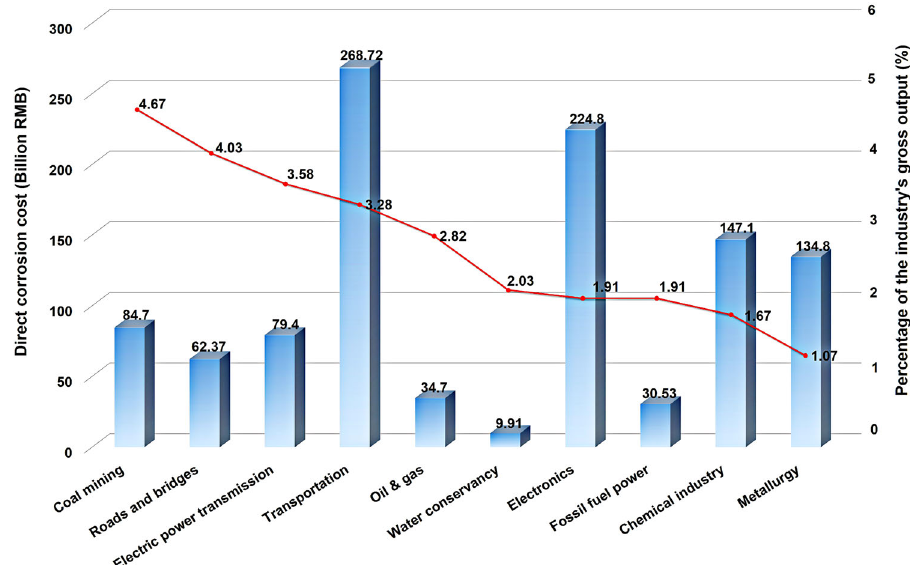
Fig. 3 The direct costs of corrosion of ten leading industries in China in